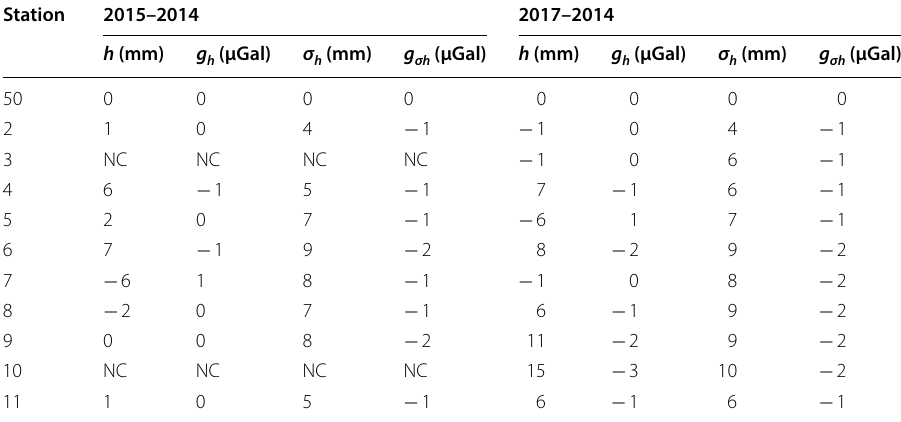
Table 1 Height differences ( h ) and their errors ( σ sous-Forêts network compared to 2014